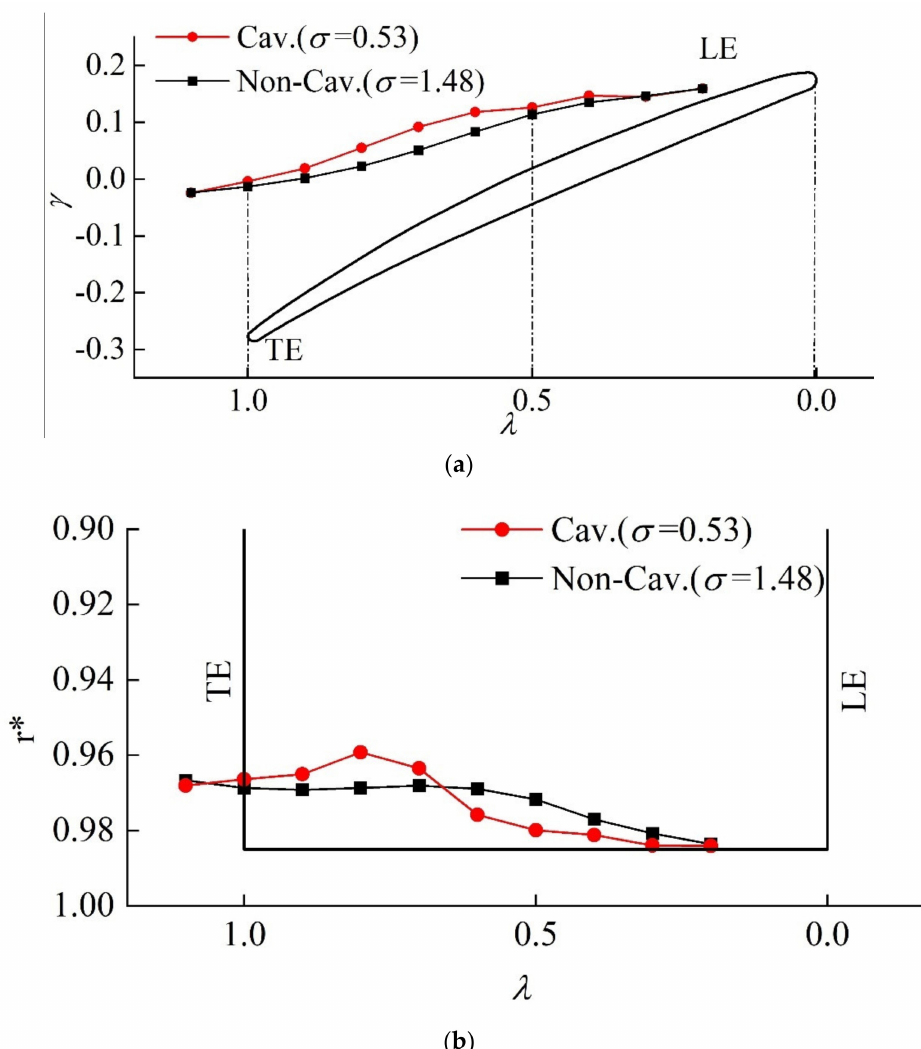
Figure 9. Trajectory of TLV core. ( a ) Axial distribution; ( b ) Radial